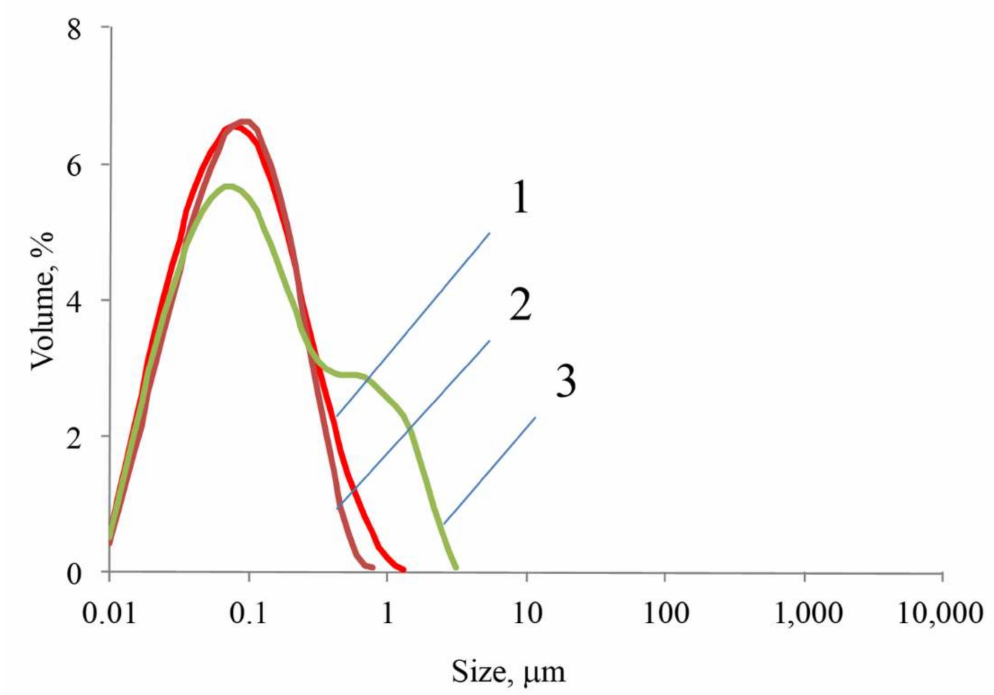
Figure 8. Particle size distribution upon chitosan condensation on SNPs from acid solutions: (1) acetic acid; (2) oxalic acid; (3) citric